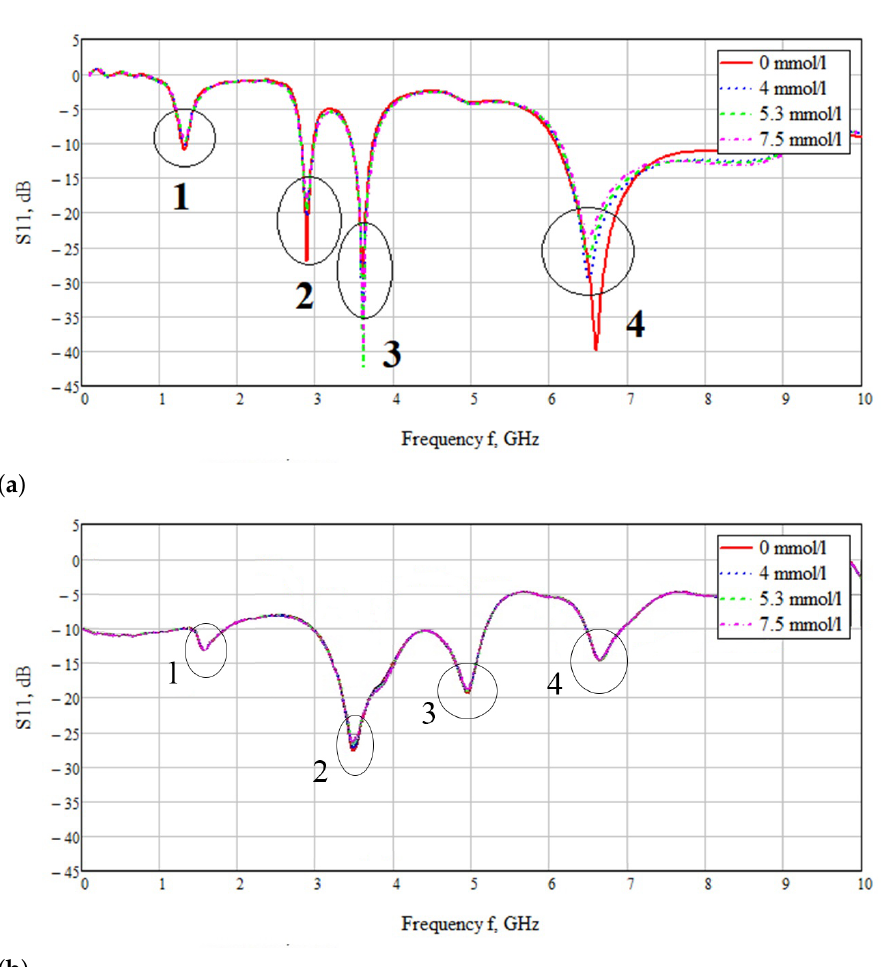
Figure 16. Frequency dependence of the reflected signal of a bidirectional probe on frequency for various glucose concentrations in modeling ( a ) [18] and experimental measurement ( b ).